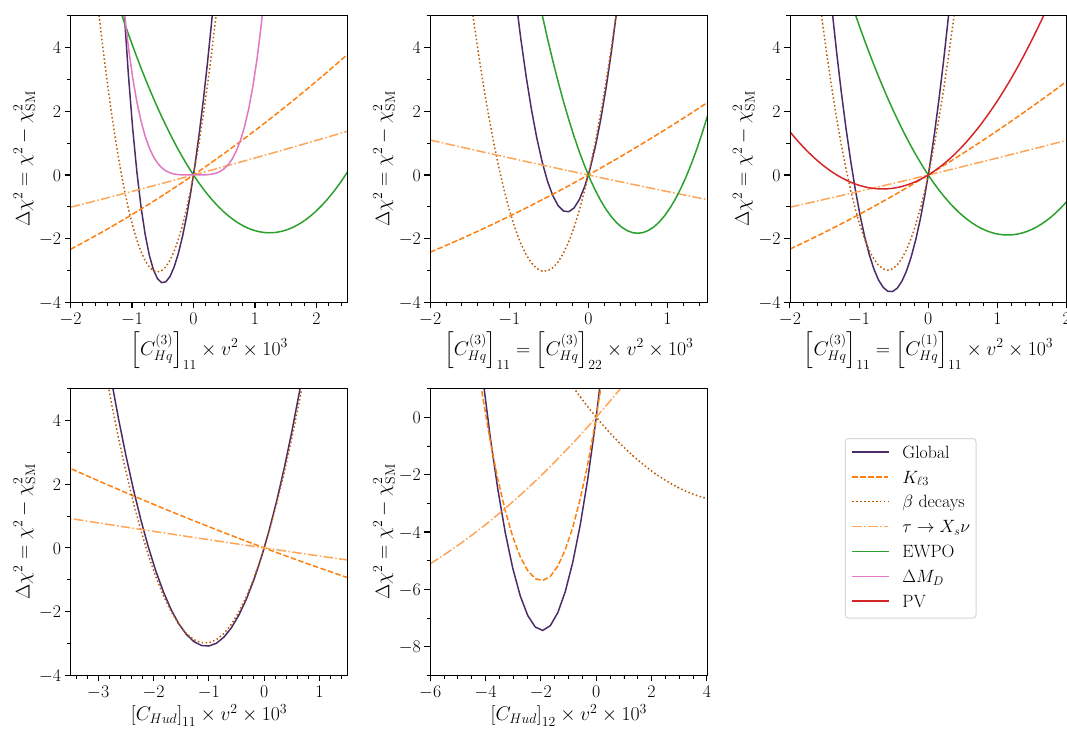
Figure 5 . ∆ χ 2 w.r.t. the SM as a function of the values of the Wilson coefficients for the 1D scenarios considered in the main text.